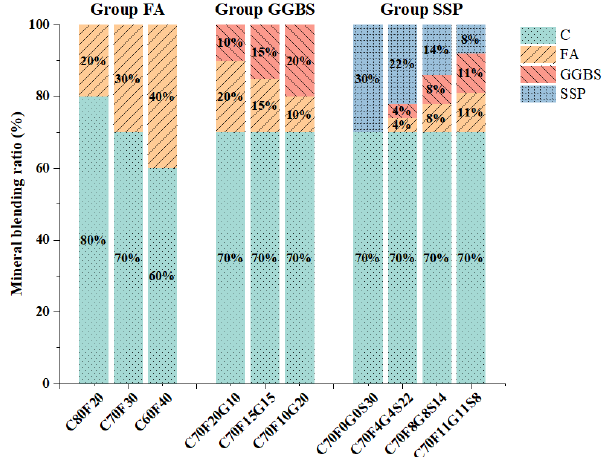
Figure 3. Experimental design. Table 6. Design of concrete mix per cubic meter